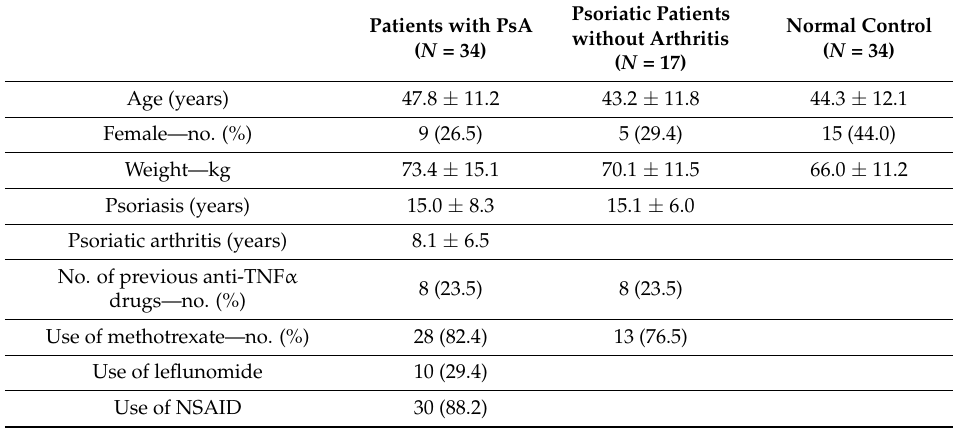
Table 1. Demographics and clinical characteristics of psoriatic arthritis (PsA) patients, psoriatic patients without arthritis and normal